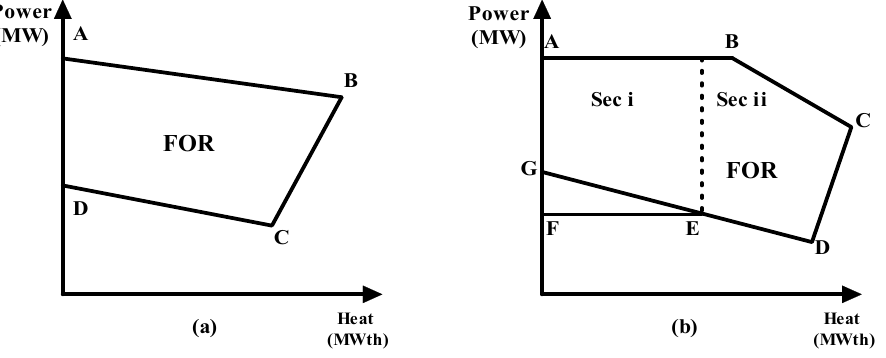
Figure 5. Feasible operating region ( a ) Type 1, ( b ) Type 2.